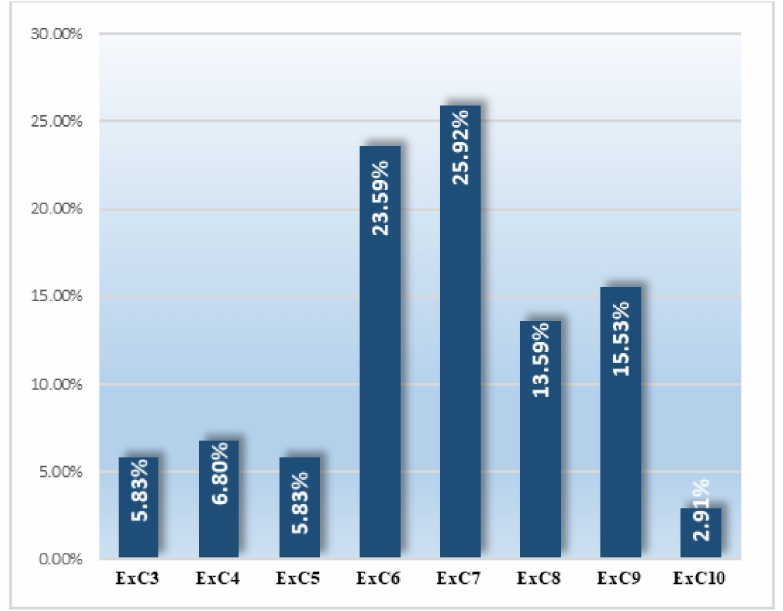
Figure 6. Percentage of papers excluded for each exclusion criterion after 2nd